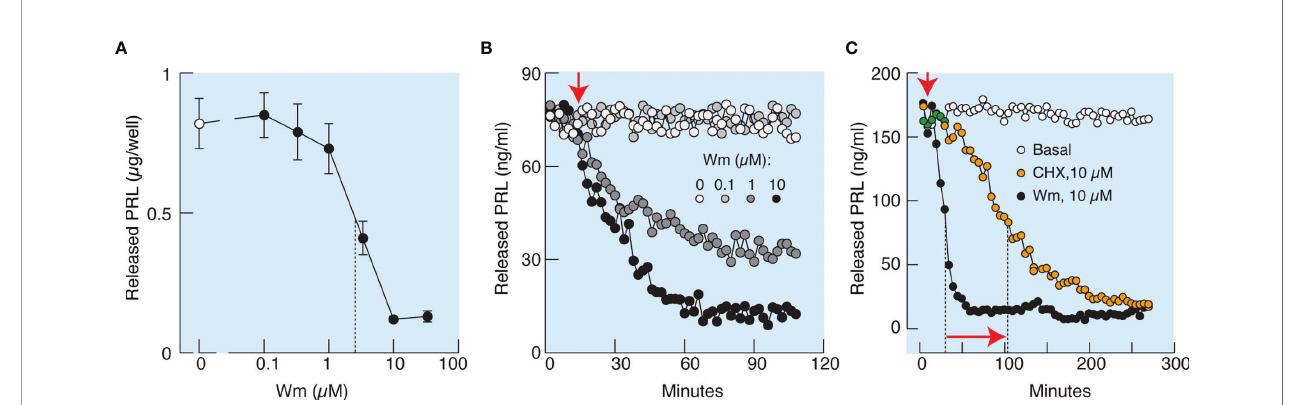
FIGURE 4 | Characterization of Wm-inhibition of basal prolactin secretion in cultured anterior pituitary cells. (A, B) Concentration-dependence of Wm effect on prolactin (PRL) release in pituitary cells in static cultures during 3 h incubation (A) and in perfused pituitary cells (B) . Vertical dotted line in (A) indicates the IC 50 value. In subsequent experiments, Wm was used at 10 µM concentration. (C) Comparison of the time-course of effects of Wm (black circles) and cycloheximide (CHX), a protein synthesis inhibitor (orange circles), on basal PRL release. Note the different time scale of this experiment vs . panel (B) . Vertical dotted lines indicate time points when 50% decrease of hormone secretion was reached, horizontal arrow indicates the difference in half-times, and vertical arrow indicates the beginning of continuous treatments with Wm and CHX. Data points shown in panel A are mean ± SEM of sextuplicate incubation and data shown in panels (B, C) are representative from two experiments. In this and following fi gures, PRL was measured by radioimmunoassay, unless stated